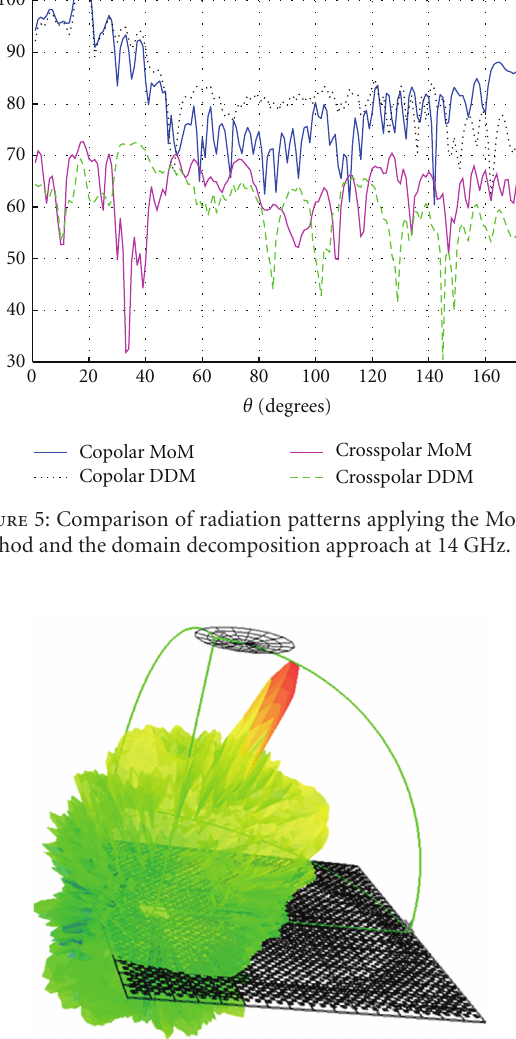
Figure 6: 3D pattern